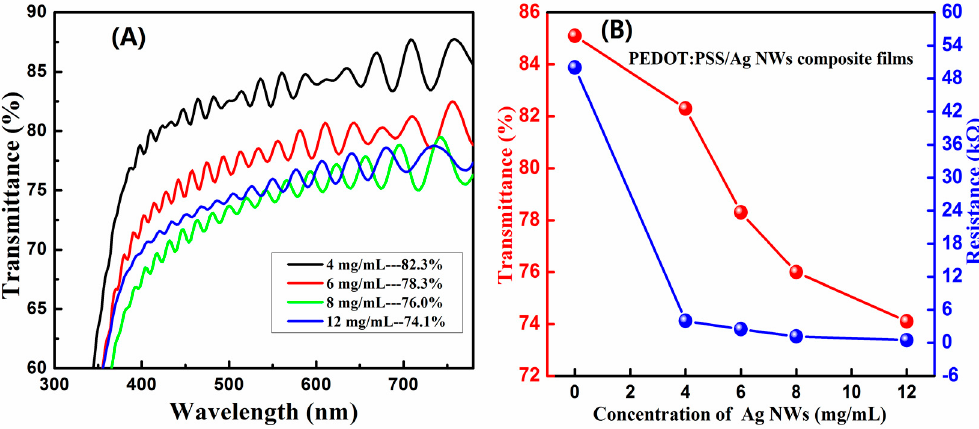
Figure 4. ( A ) Optical transmittance spectra and ( B ) the variation of the transmittance at 550 nm and resistance of PEDOT:PSS/Ag NW composite films printed using the 350 mesh with the concentration of Ag NWs ranging from 4 to 12 mg/mL.